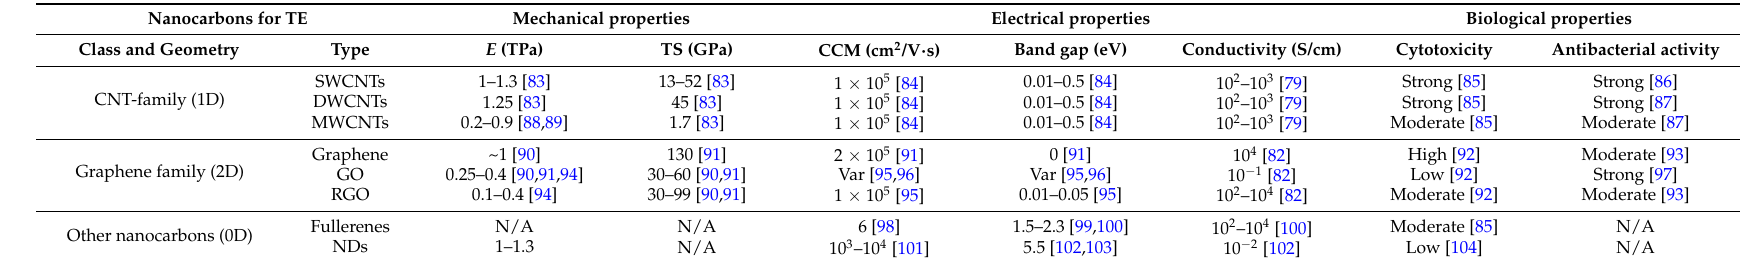
Table 1. Nanocarbons examined in this review: some properties of